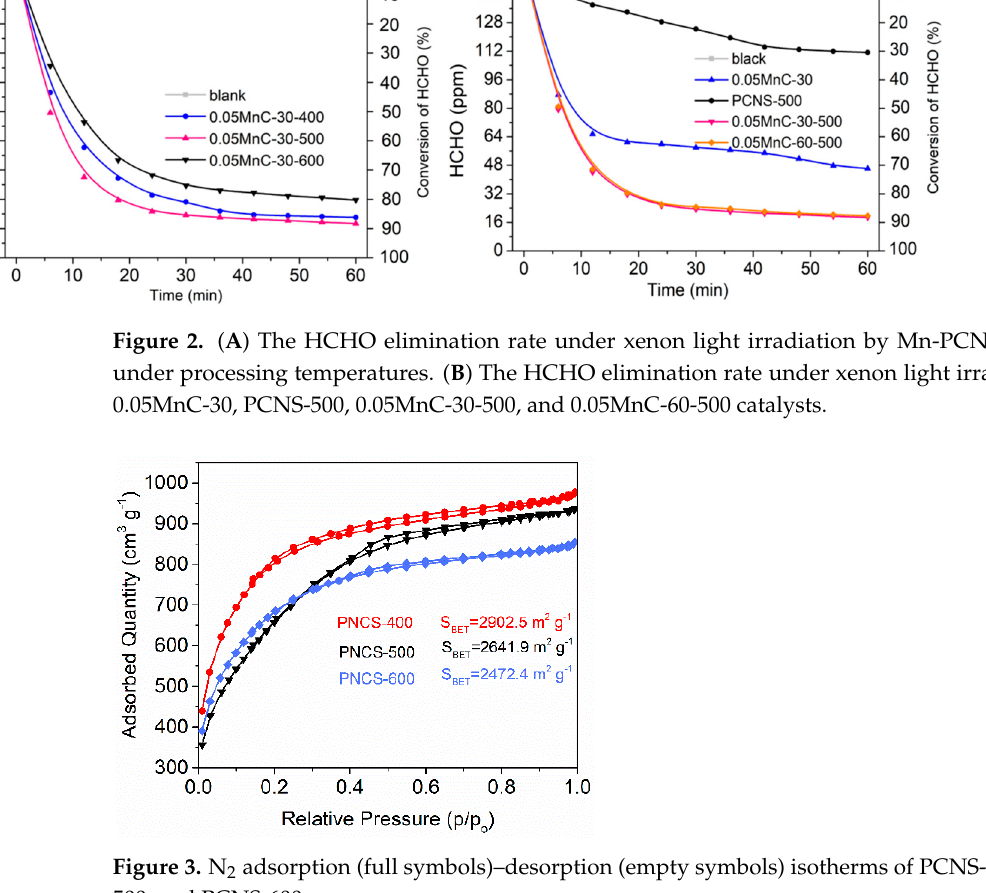
Figure 3. N 2 adsorption (full symbols)–desorption (empty symbols) isotherms of PCNS − 400, PCNS − 500, and PCNS − 600.